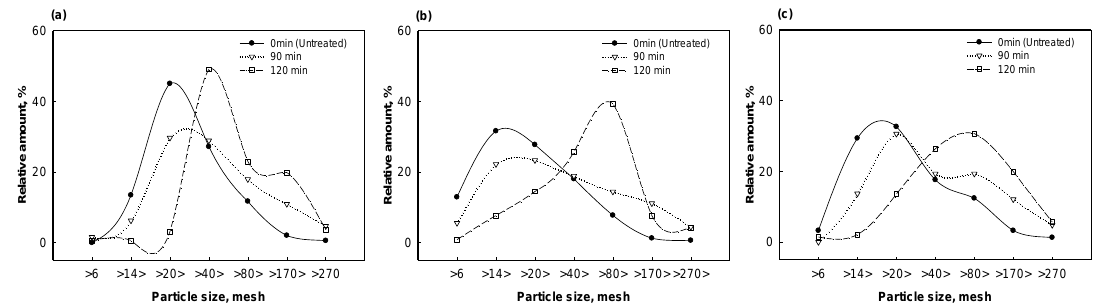
Figure 2. Biomass particle size distributions before and after the combined physicochemical pretreatment at different reaction times: ( a ) GM; ( b ) CS; and ( c ) WS.